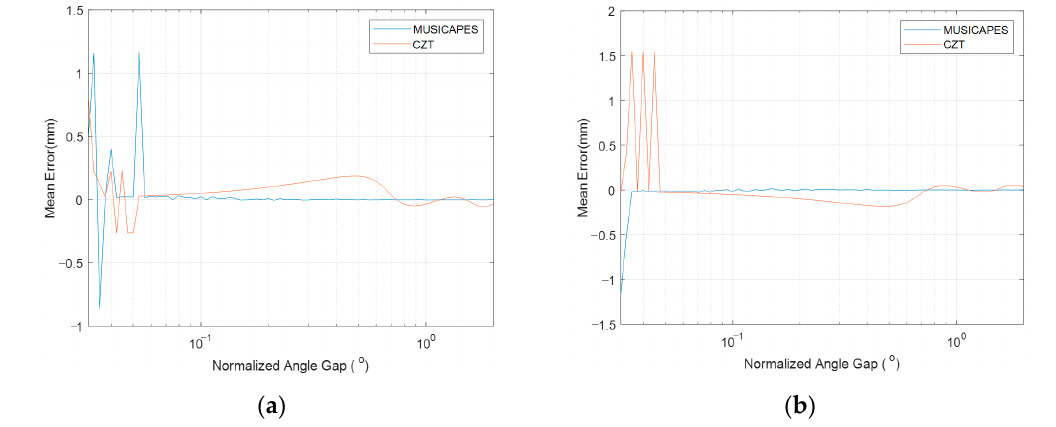
Figure 7. Mean error of displacement difference vs. angle interval. ( a ) The mean error of ‘Target1’; ( b ) the mean error of ‘Target2’.